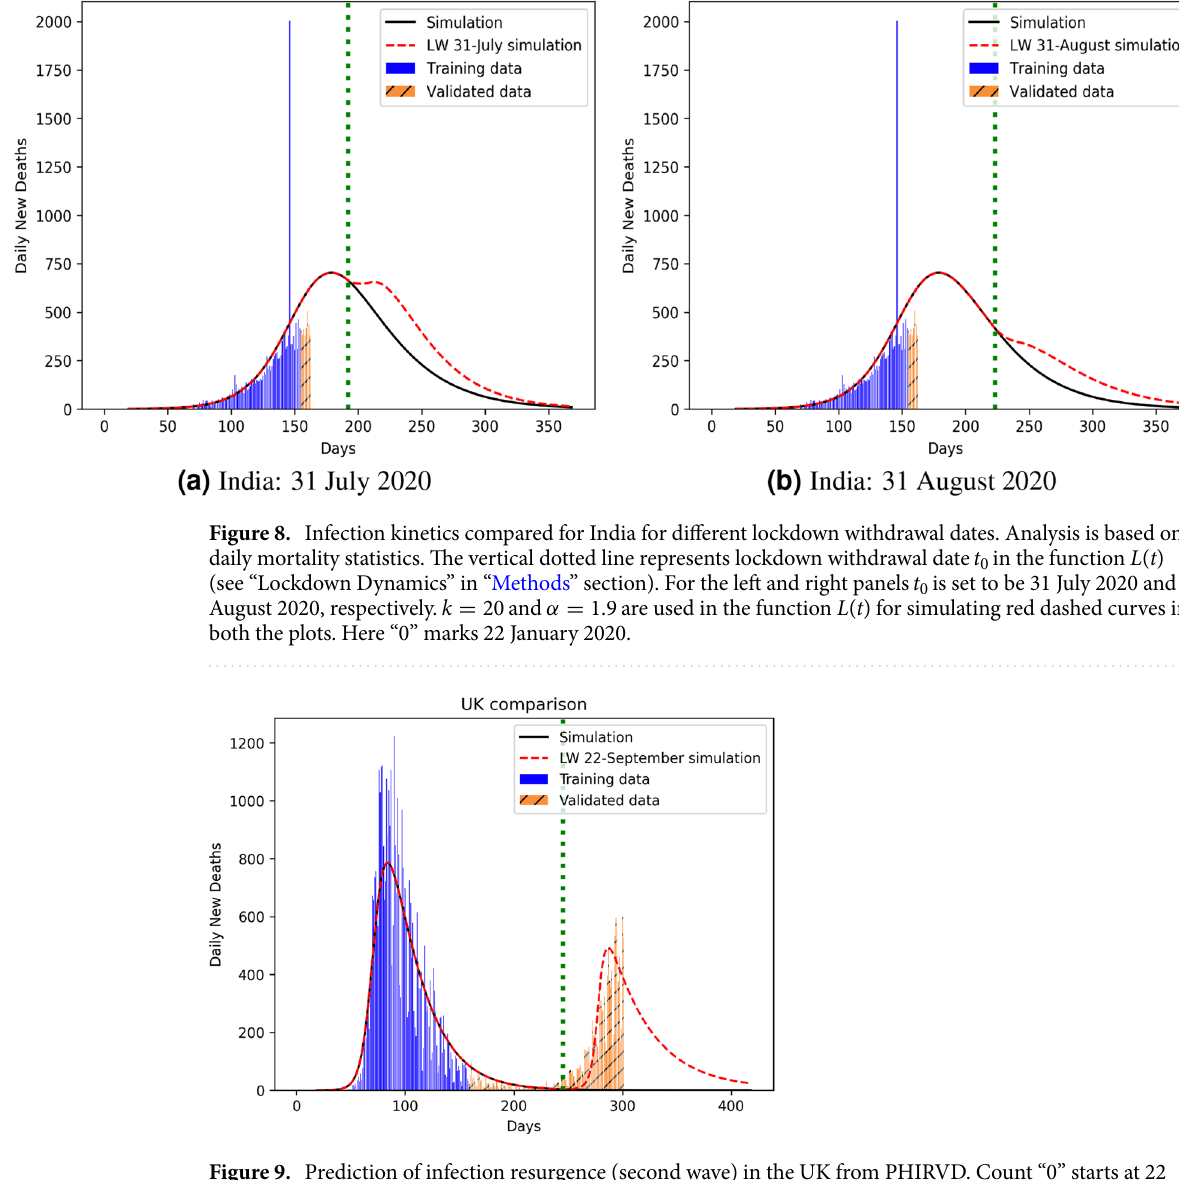
Figure 9. Prediction of infection resurgence (second wave) in the UK from PHIRVD. Count “0” starts at 22 January 2020. MCMC training performed between 10 February 2020 to 29 June 2020, excluding data for the first 19 days (statistics recorded 22 January 2020 onwards) due to low infection. The second wave is simulated by setting t 0 = 22 September 2020 (marked by the vertical dotted line), k = 450 , and α = 35 , in the function L ( t ) (see “Lockdown Dynamics” in “Methods”